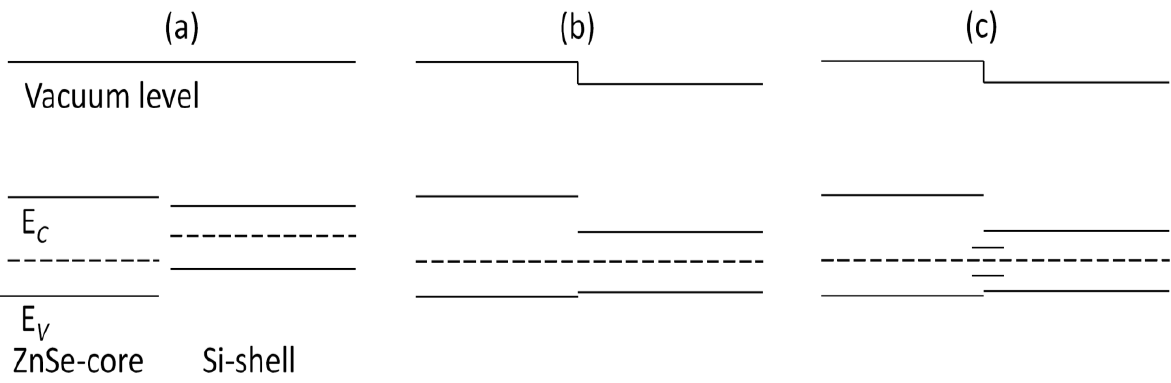
Figure 9. The band alignment of ZnSe-core/Si-shell NWs ( a ) before and ( b ) after the formation of heterostructures; ( c ) the band alignment of NWs with interface